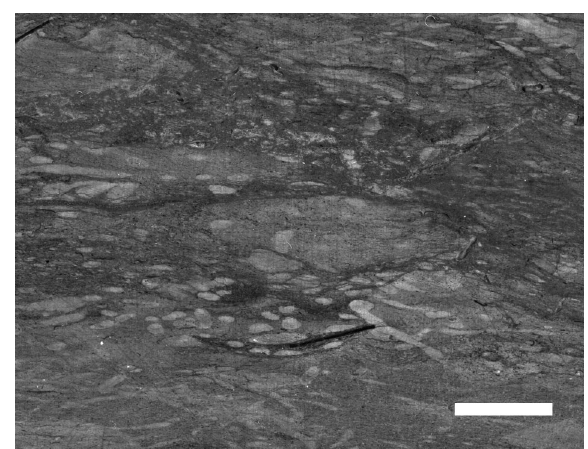
Fig. 3. Enlarged image from the middle of the shale showing a concentration of Chondrites traces. Note that some have been compacted vertically. The scale bar is 1 cm.